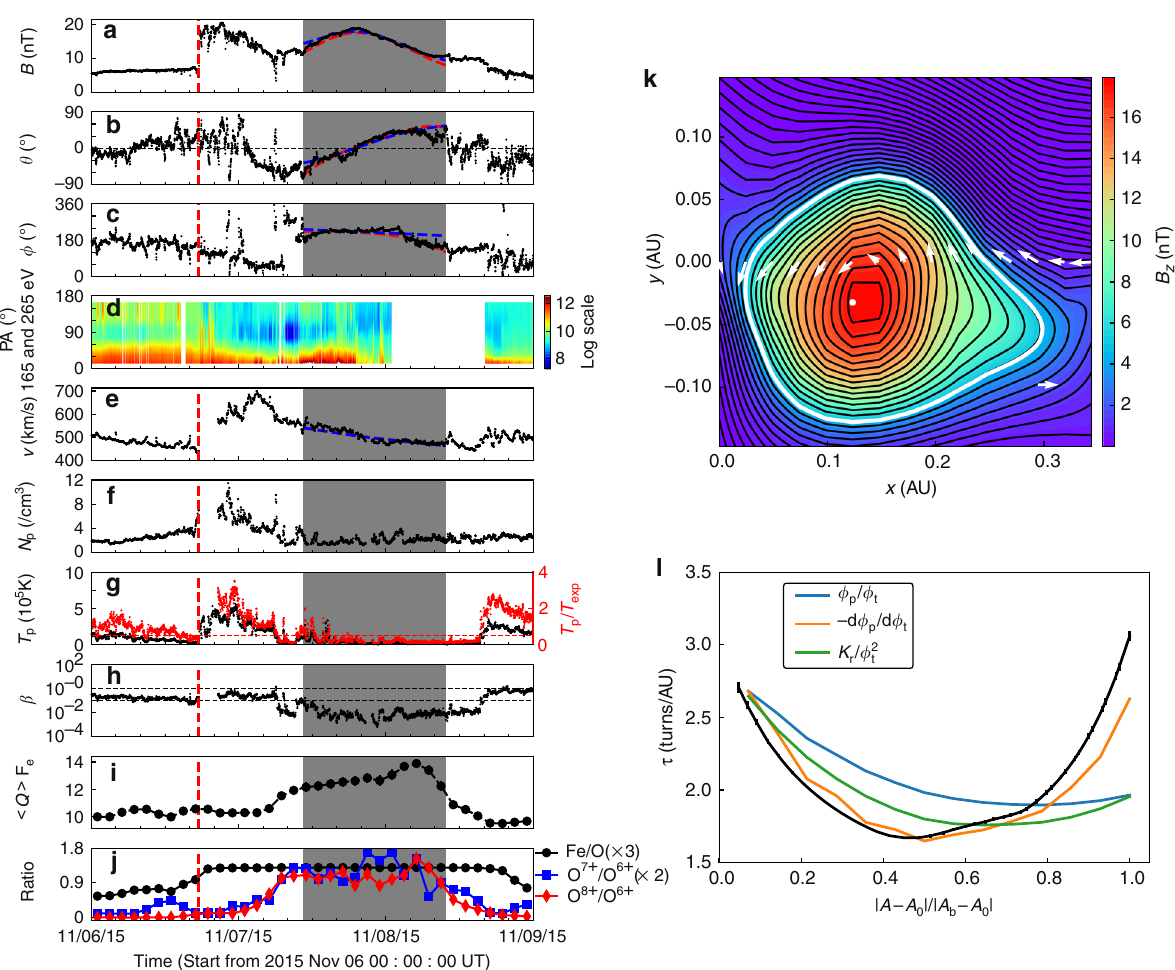
Fig. 4 In situ diagnostics and analysis. a In situ observation of the magnetic cloud (MC; shaded region) preceded by a shock (red vertical line). All data except suprathermal electrons (WIND spacecraft) were obtained by the Advanced Composition Explorer (ACE) spacecraft. a Field magnitude B ; b fi eld inclination angle θ (with respect to the ecliptic plane); c azimuthal angle ϕ (0 deg pointing to the Sun), d pitch angle distribution of suprathermal electrons; e solar wind speed V ; f proton density N p ; g temperature T p (superimposed by T p / T exp ); h plasma β ; i average charge states of iron Q h i Fe = ∑ i Q i n i (density is normalized such that ∑ i n i = 1), and j various composition ratios. The dashed lines in a – c , e show the model fi tting results with red (blue) indicating the Gold-Hoyle (Lunquist) solution (Methods section). k , l Grad-Shafranov reconstruction (Methods section) of the MC. k Shows the reconstructed cross section traversed by ACE. The fl ux function A ( x , y ) is represented by the black contours. The thick white contour marks the MC boundary A b = 38.9 T · m. The strength of axial fi eld B z ( A ) is indicated by colors, with the maximum marked by a white dot. The measured magnetic fi eld vectors are projected along the spacecraft path y = 0 (white arrows). l shows the twist τ of MC fi eld lines (black line) as a function of A (cid:2) A 0 j j = A b (cid:2) A 0 j j . A 0 = 160.4 T · m gives